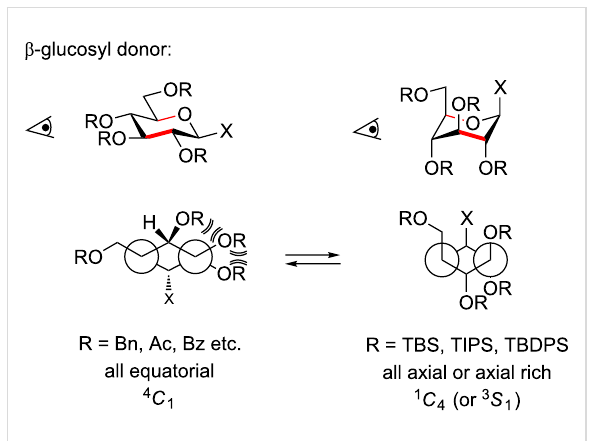
Figure 3: Conformational change induced by bulky vicinal protective groups such as TBS, TIPS and TBDPS. The vicinal clash overrules the 1,3-diaxial interaction, which is less influenced by bulky silyl ethers as these can rotate more freely in the axial-rich conformation. The projec- tions are along the red bonds in the two